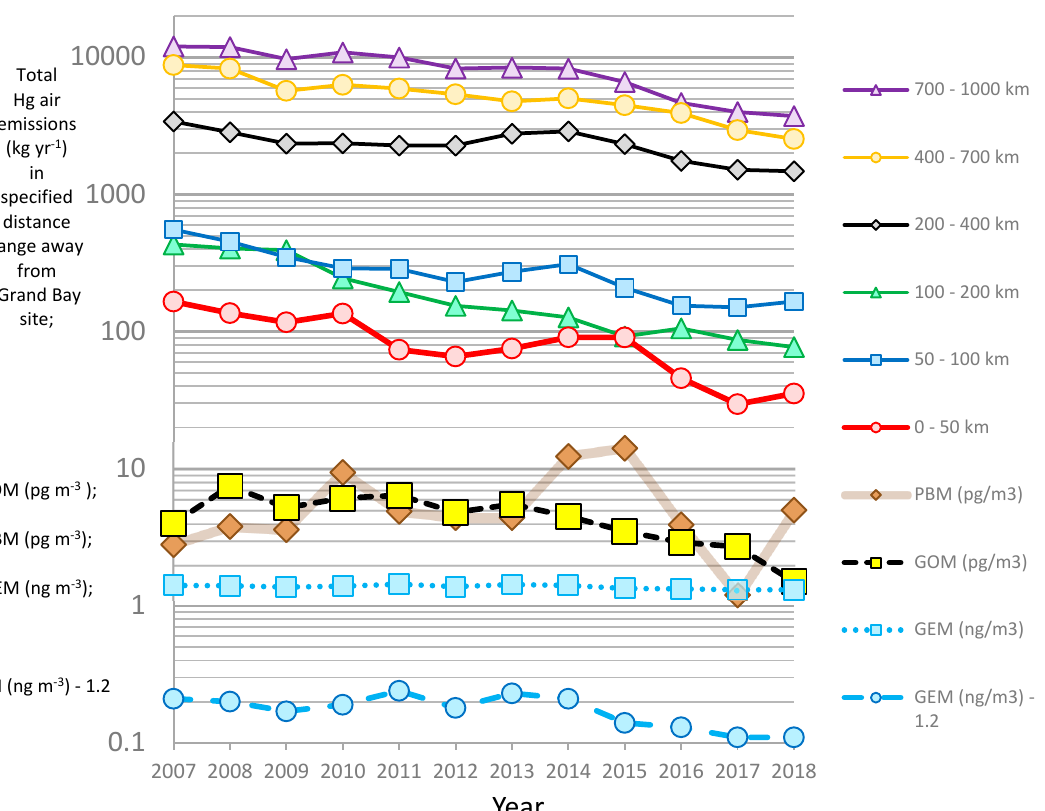
Figure 5. Time series of point-source anthropogenic mercury air emissions in different distance ranges away from the Grand Bay site [19] and annual mean concentrations of GEM, GOM, and PBM from 2007 to 2018. The mean concentrations of GEM minus a hypothetical background concentration of 1.2 ng m − 3 is also shown.